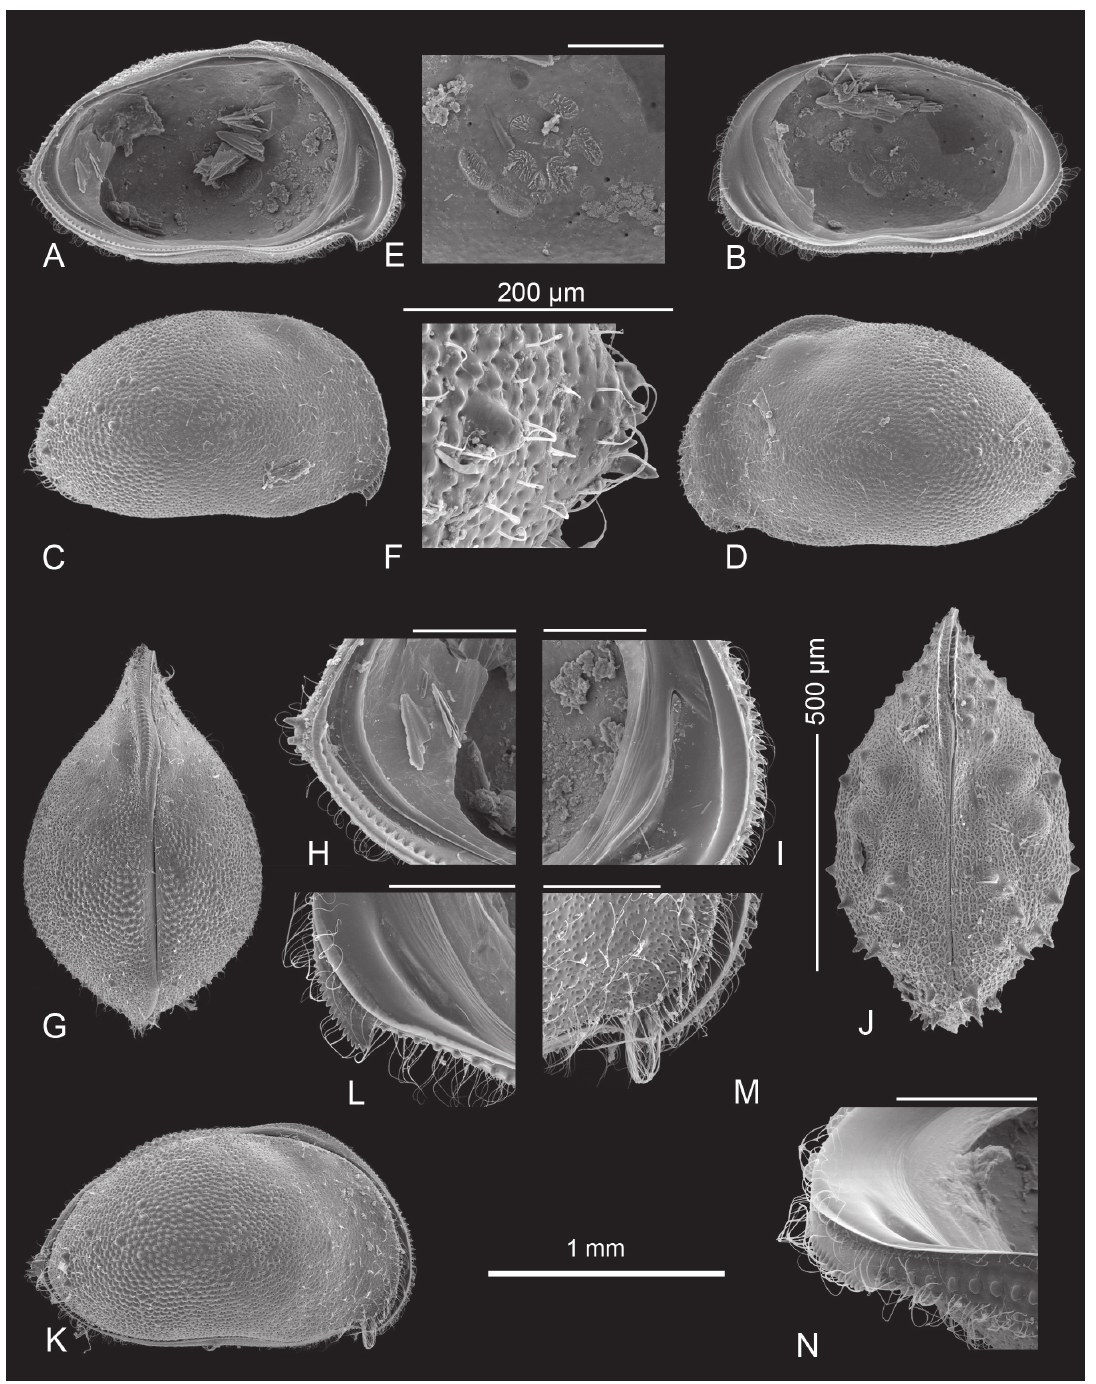
Fig. 4. Bennelongia nimala De Deckker, 1981 (all ♀, all from Kakadu National Park, NT). A . lVi (WAMC55593). B . RVi (WAMC55593). C . RVe (WAMC55589). D . LVe (WAMC55589). E . rVi, detail of central muscle scars (WAMC55593). F . LVe, detail of surface ornamentation (WAMC55589). G . CpD (OC3373). H . LVi, detail of caudal side (WAMC55593). I . lVi, detail of anterior side (WAMC55593). J . CpD (juvenile A-3, specimen lost). K . CpRL (OC3373). L . rVi, detail of anterior margin (WAMC55593). M . CpRL, detail of anterior margin, showing external view of lapel (OC3373). N . RVi, tilted, detail of anterior margin and of lapel (WAMC55593). Scale = 1 mm for A–D, G, K; 500 µm for J; 200 µm for E–F, H–I,